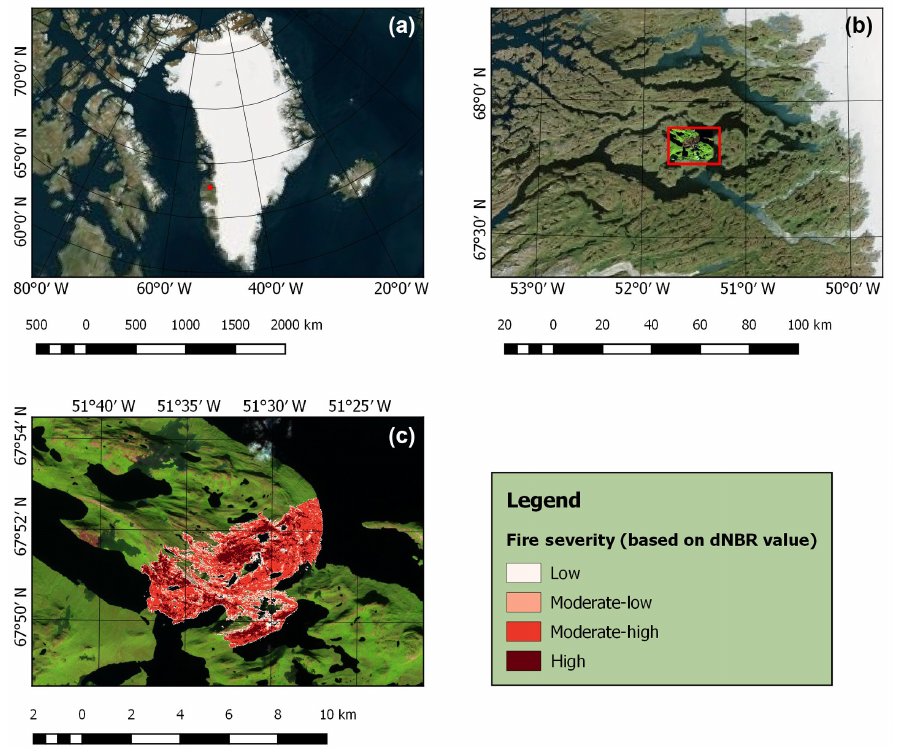
Figure 1. Map of Greenland (a) and close-up map marked with fire location (b) and burned area classification (c) in terms of fire severity according to Sentinel-2A images for fires burning in Greenland in August 2017. To delineate fire perimeters, both Landsat 8 OLI and Sentinel-1A–2A data were used (Table